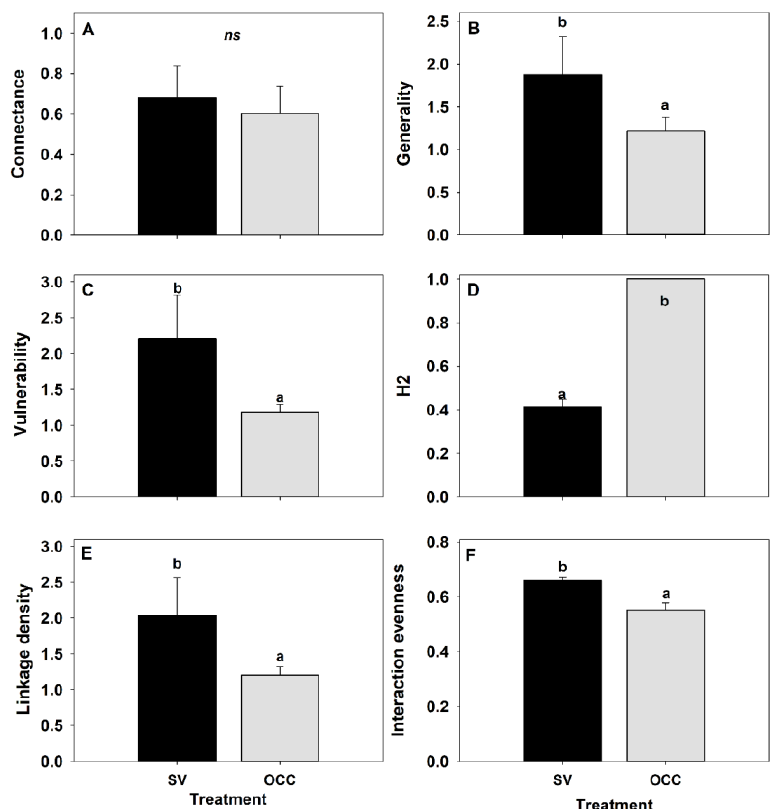
Figure 3. Food web metrics of the plum orchards in Chile with spontaneous vegetation (SV) and with oat cover crop (OCC). ( A ) Connectance, ( B ) Generality, ( C ) Vulnerability, ( D ) H2, ( E ) Linkage density, and ( F ) Interaction evenness. Different letters indicate significant differences between treatments and ‘ ns ’ indicates non-significant differences.